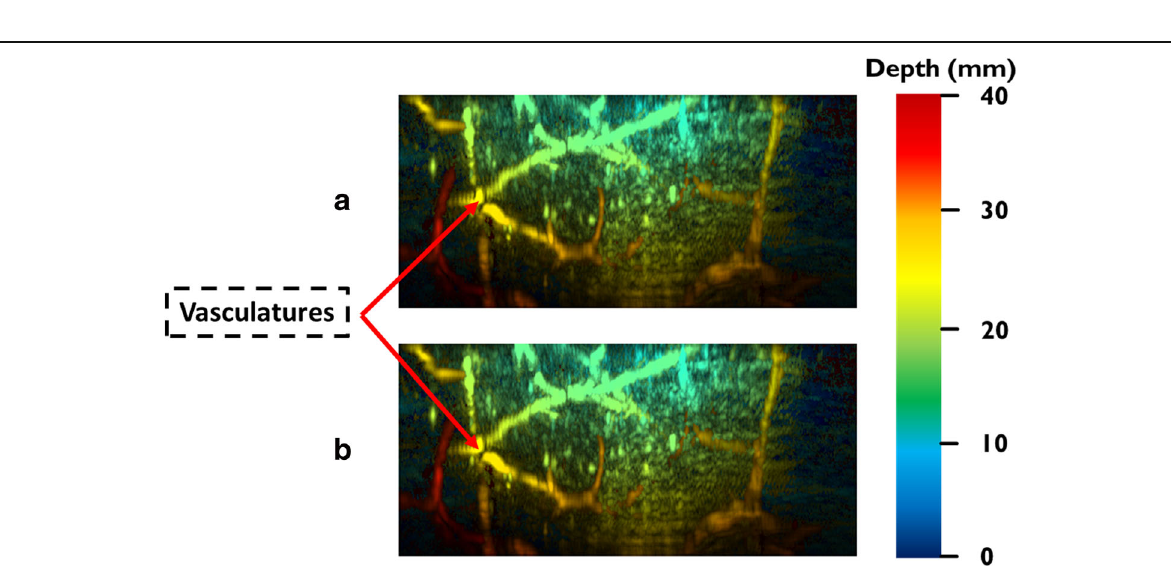
Fig. 5 Comparison of depth-encoded photoacoustic images reconstructed by the ( a ) MCC and ( b )